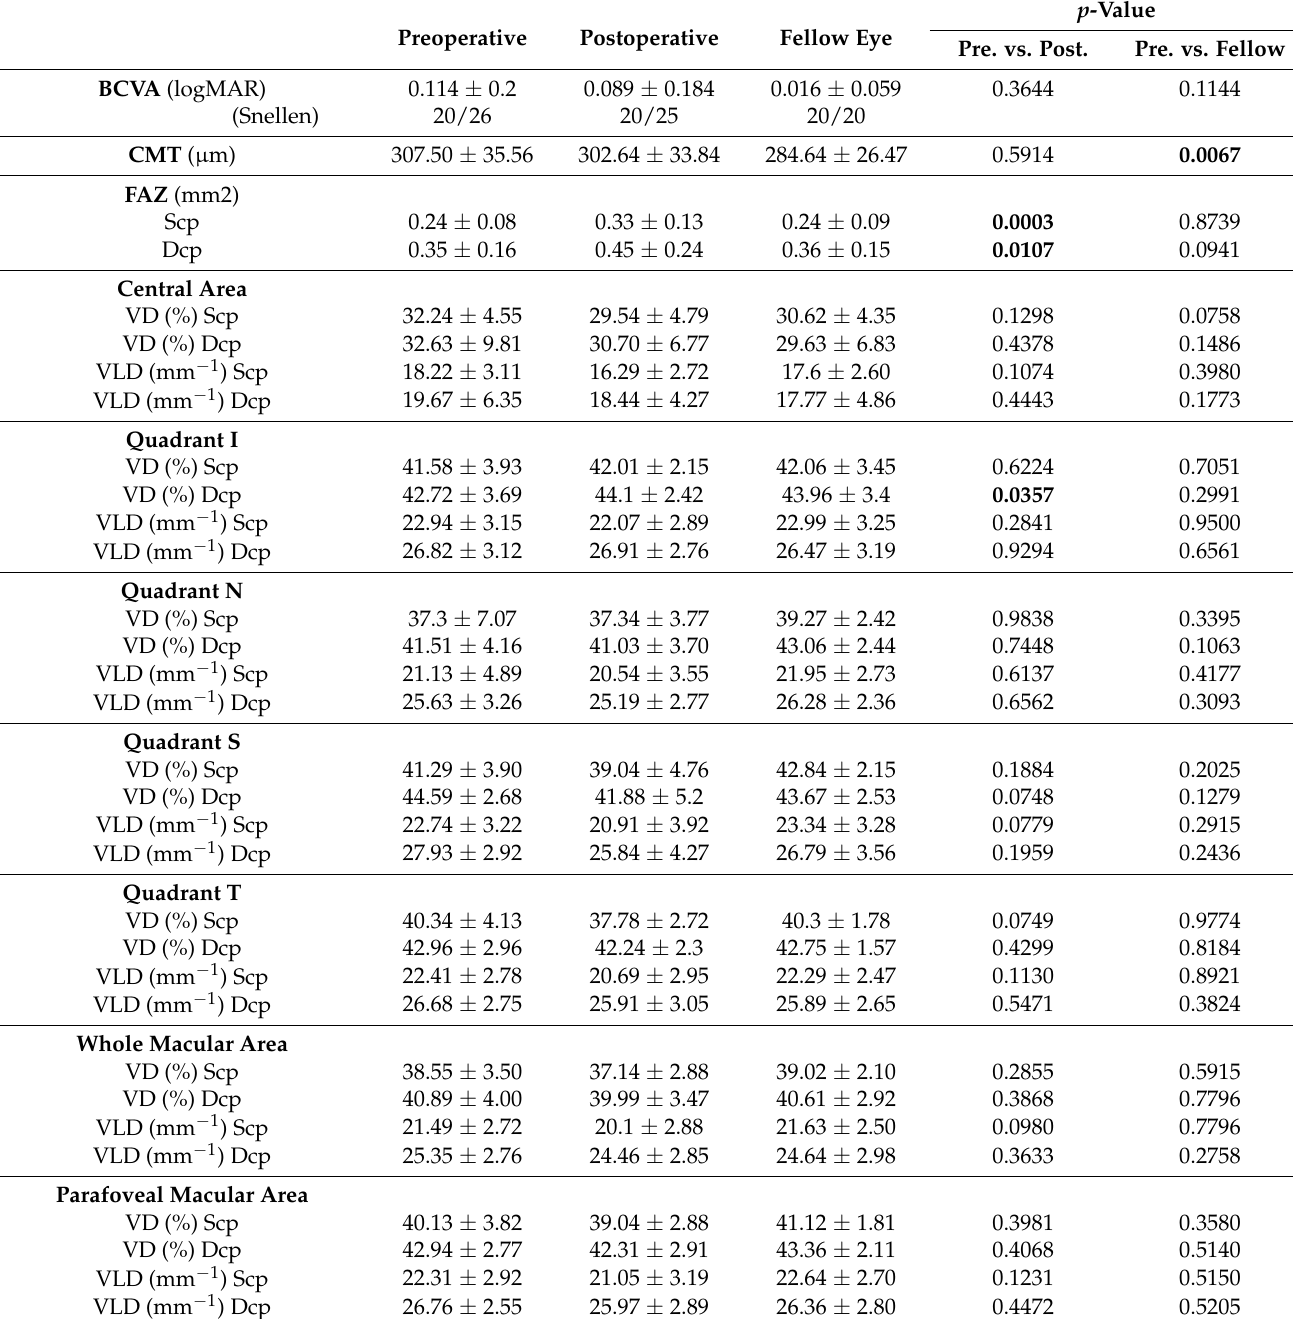
Table 2. Best-corrected visual acuity, optical coherence tomography and optical coherence tomogra- phy angiography mean